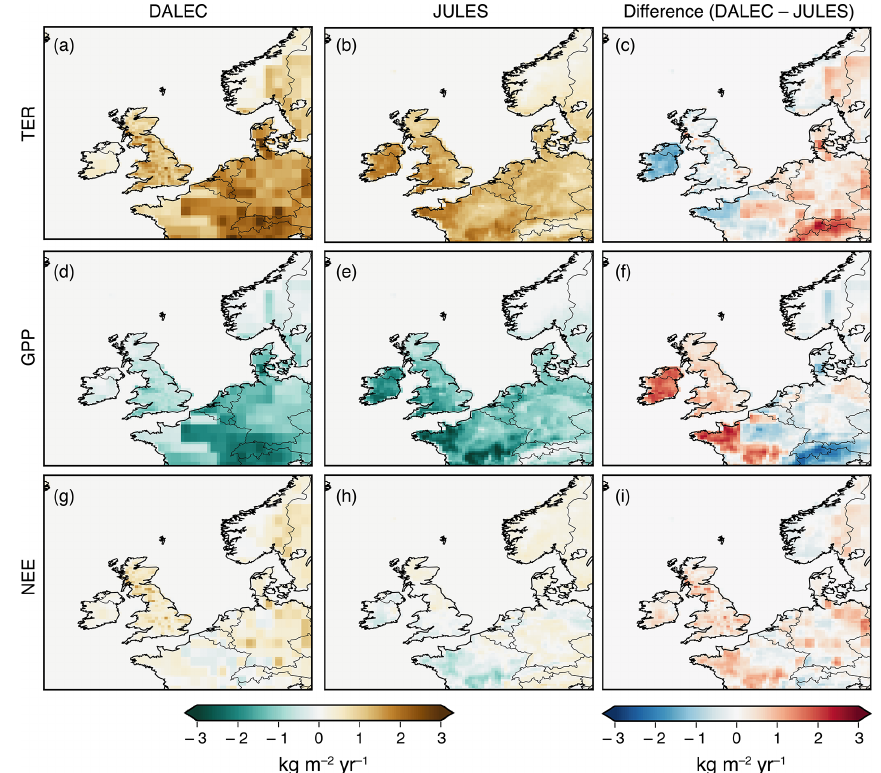
Figure 3. Average prior flux maps for winter 2013 (December 2013, January–February 2014). (a) TER from DALEC; (b) TER from JULES; (c) the difference between DALEC and JULES TER; (d) GPP from DALEC; (e) GPP from JULES; (f) the difference between DALEC and JULES GPP; (g) NEE from DALEC; (h) NEE from JULES; (i) the difference between DALEC and JULES